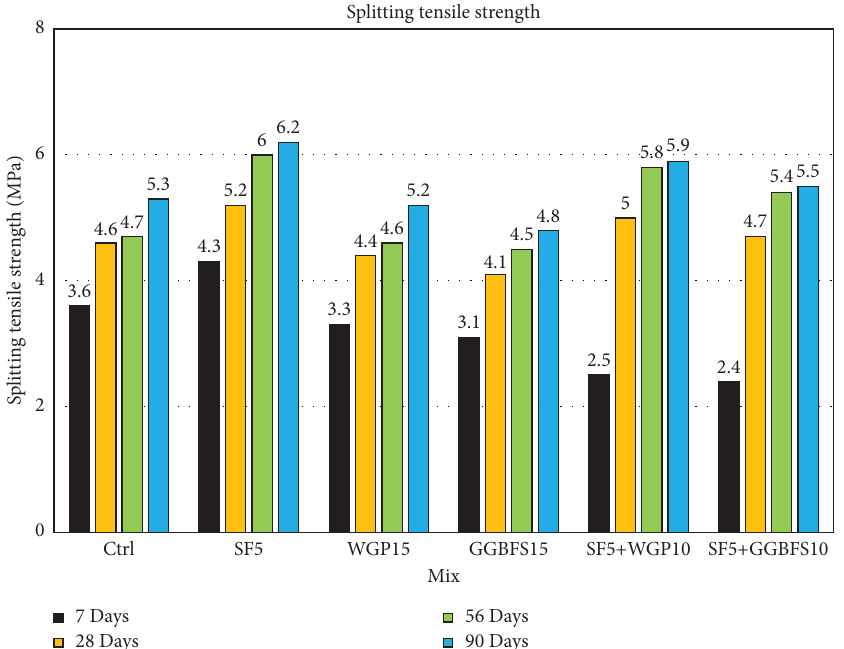
Figure 6: Tensile strength results of concrete